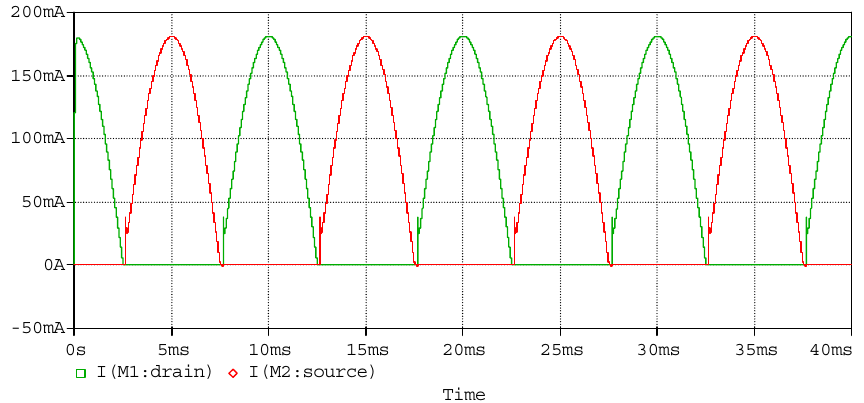
Figure 13. Simulated currents of MOSFETs.